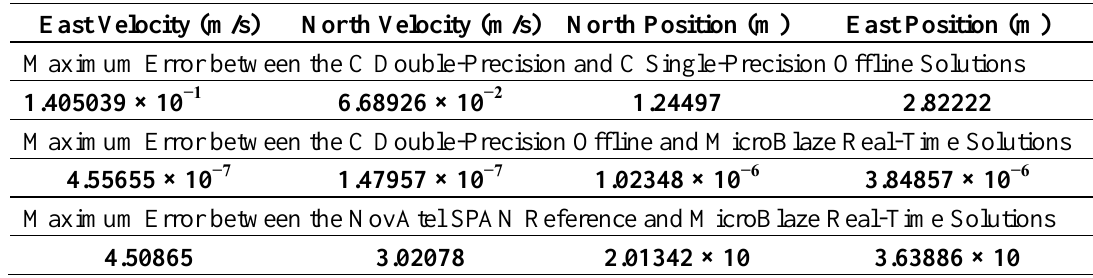
Table 8. Maximum Error in the East Velocity, North Velocity, North and East Positions over Land Vehicle Trajectory